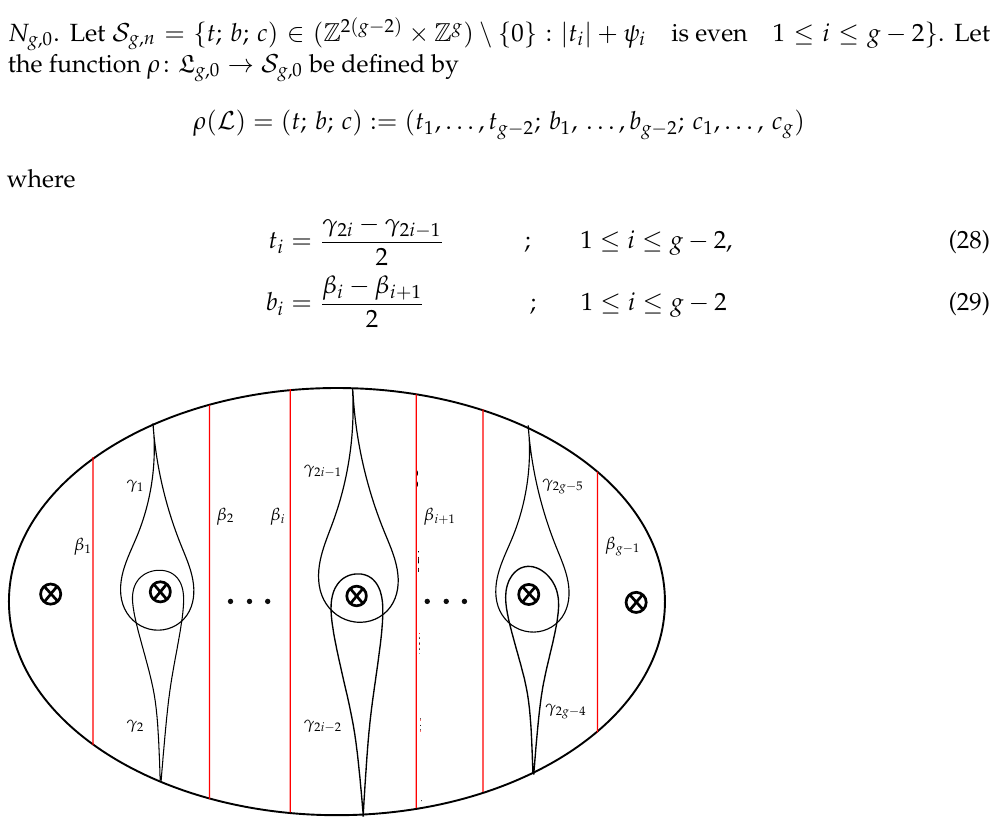
Figure 6. The arcs γ i , β i and the core curves c i on N g ,0 .